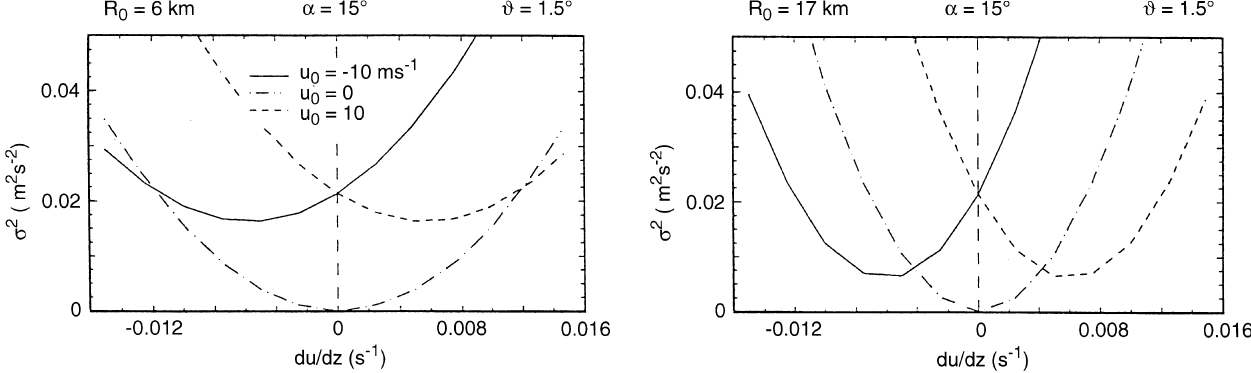
Fig. 8. As in Fig. 3, excect for typical horizontal wind speeds and for zenith distance 15 degrees and half-beamwidth 1.5 degrees at R o (cid:136) 6 and 17km